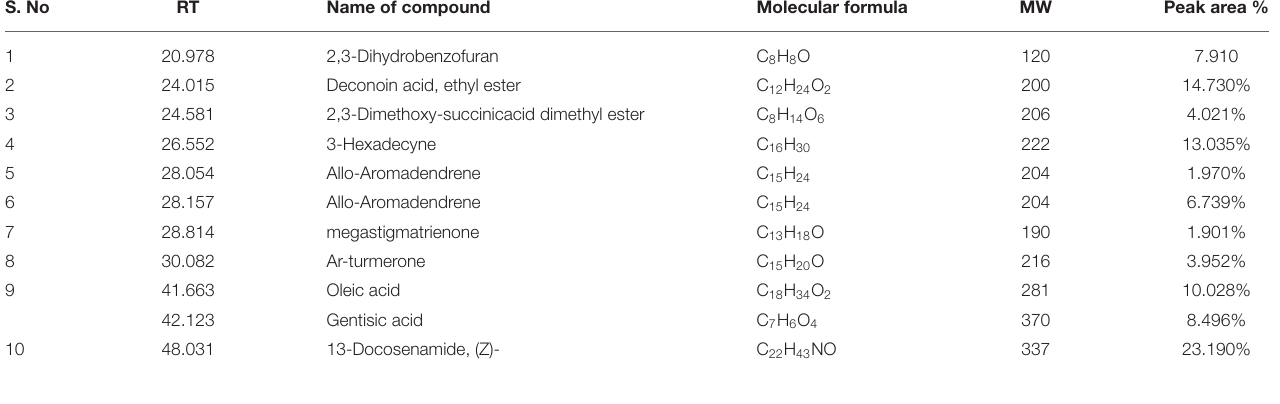
TABLE 1 | GC–MS data of the different compounds present in ethanolic extract of Annona reticulata . S. No RT Name of compound Molecular formula MW